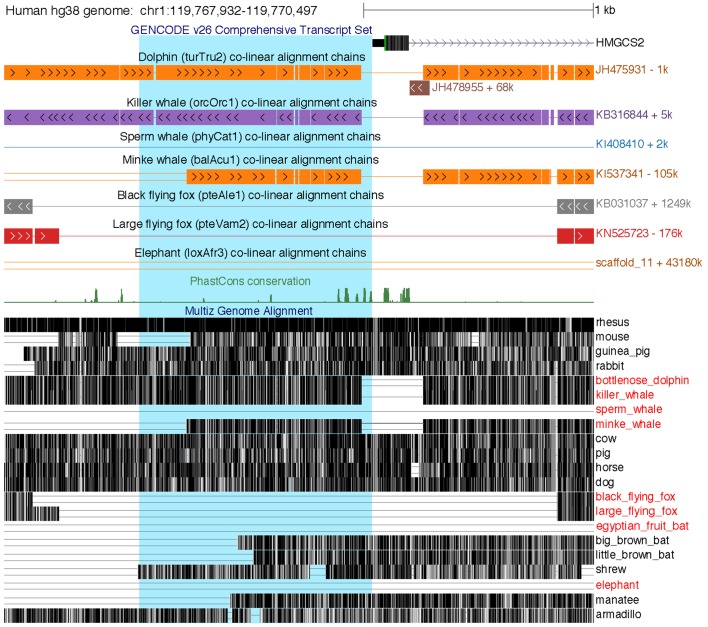
Loss of the HMGCS2 promoter region in the sperm whale, pteropodids, and the elephant.The figure shows the 2.5 kb genomic region around HMGCS2 exon 1 in the UCSC human (hg38 assembly) genome browser (Casper et al., 2018). The 1 kb region upstream of the transcription start site, highlighted in blue background, is deleted in the sperm whale and also lost in fruit bats and elephant, as shown by the co-linear pairwise alignment chains (blocks are aligning regions, a single line represents the shared deletion, double lines represent regions that do not align between the human and the query genome).